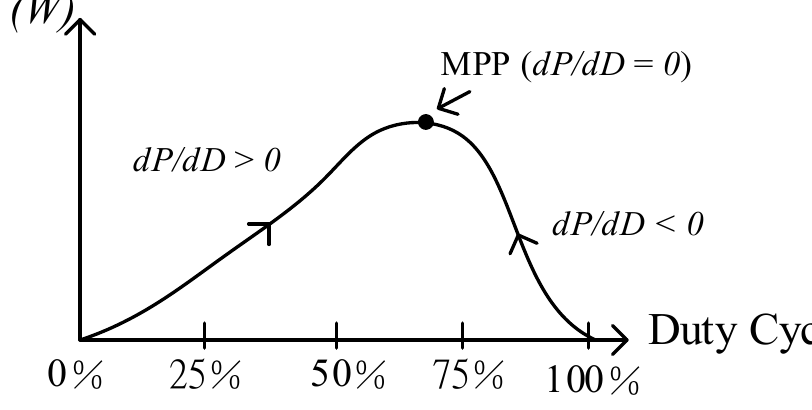
Figure 12. Perturb-and-observe method.